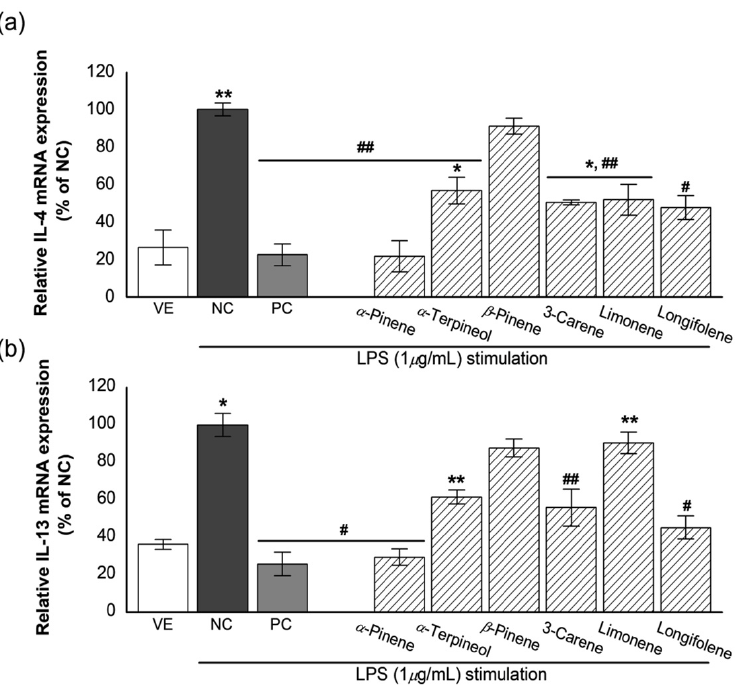
Figure 6. Effects of the single compounds on ( a ) IL-4 and ( b ) IL-13 mRNA expression in LPS- stimulated RBL-2H3 cells. VE: vehicle, DMSO; NC: negative control, 1- µ g/mL LPS treated group; PC: positive control, 100-nM dexamethasone treated group, the single compounds (10 − 7 %). Values are presented as mean ± standard deviation. * p < 0.05 and ** p < 0.01 compared with VE; # p < 0.05, ## p < 0.01 compared with NC.